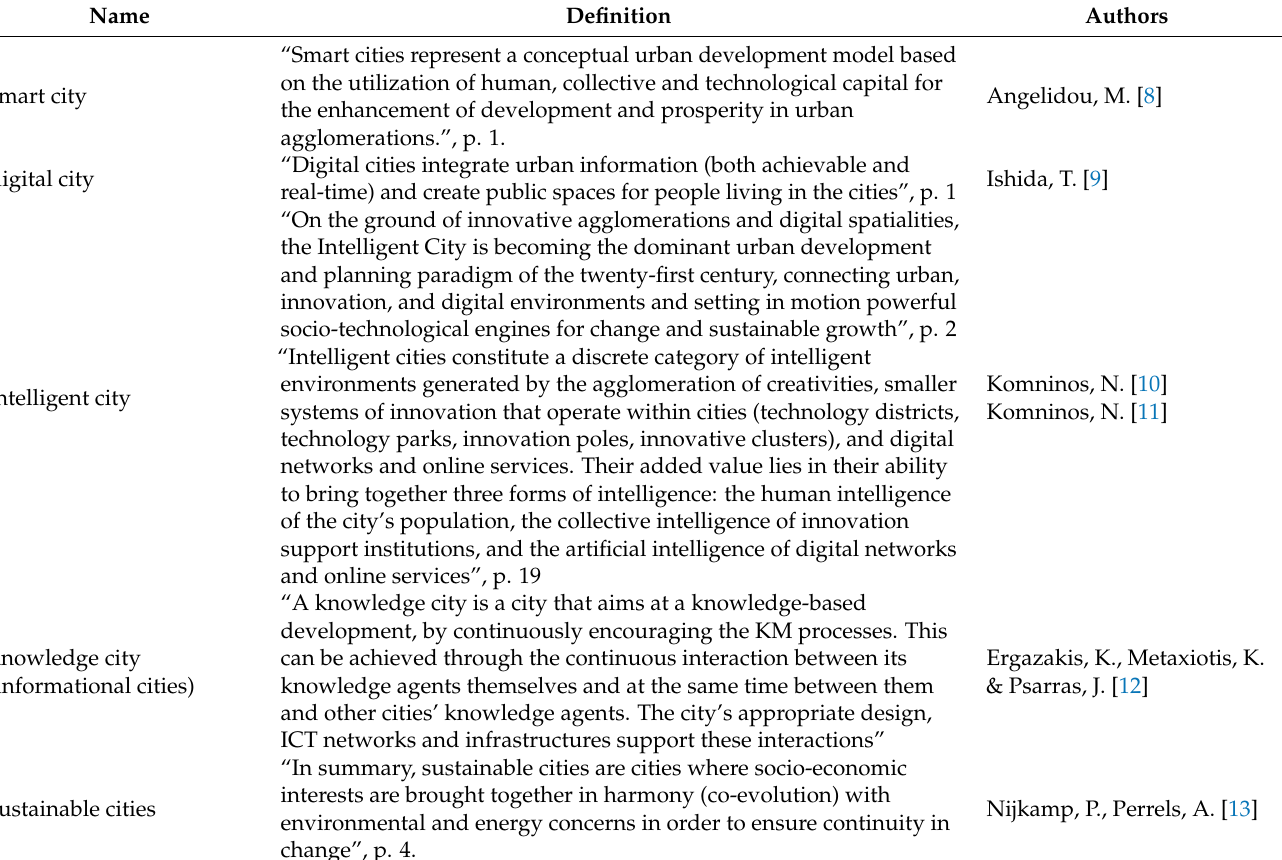
Table 1. Example definitions of modern city